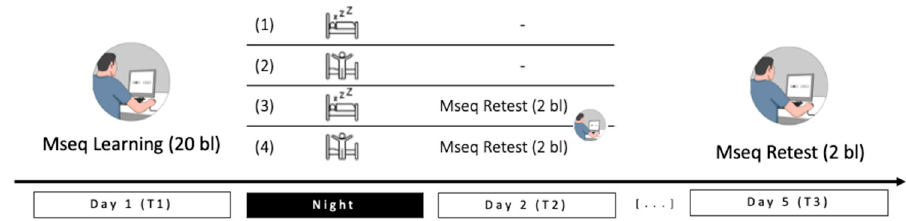
Figure 1. Experimental design and groups: Participants were trained on Day 1 in the late afternoon on 20 SRTT blocks, then groups 1 and 3 were allowed to sleep for the night (RS) while groups 2 and 4 spent the night awake (SD). In the morning of Day 2, groups 3 and 4 performed a 2-block retest (Reactivation condition). After three nights of sleep at home, all groups came back to the lab for a final 2-block retest (Day 5). Mseq: motor sequence task.